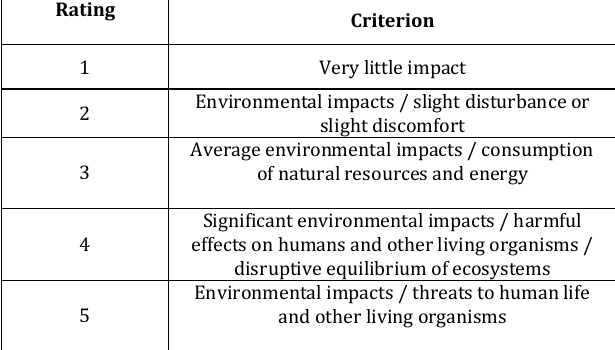
Table 3: The severity of environmental